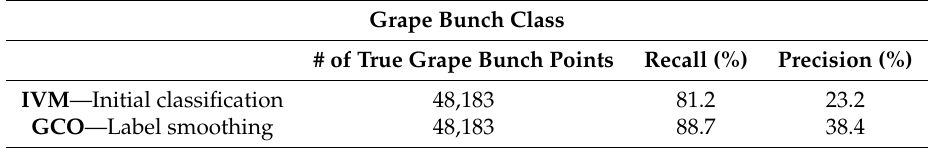
Table 2. Grape bunch class recall and precision for the classification of the SMPH grapevine row.